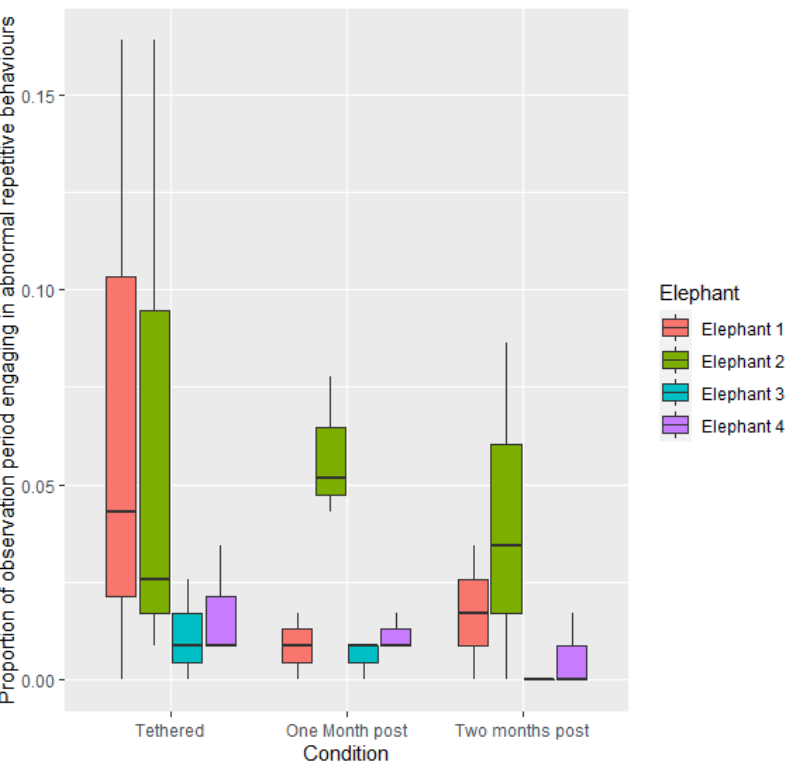
Figure 5. Mean proportion of time spent engaging in abnormal repetitive behaviours per observa- tional period during the three conditions.